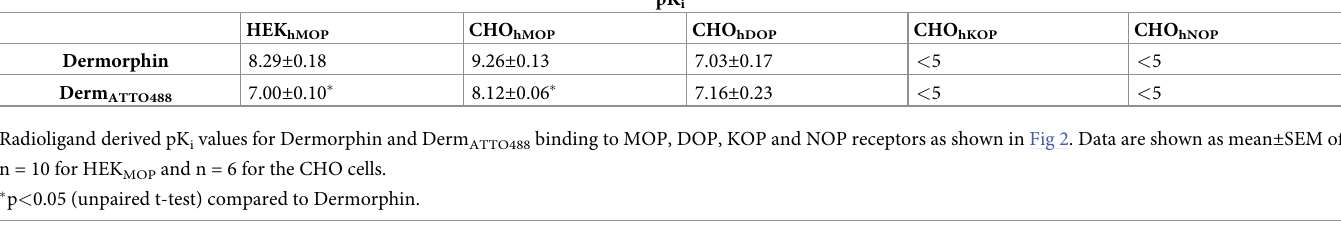
In CHO Dermorphin and Derm stimulated GTP γ [ 35 S] binding in a concentra- hMOP ATTO488 tion dependent and saturable manner. The maximal response of Derm (E 1.34) was ATTO488 max not significantly different (p > 0.05) to that calculated for Dermorphin (E 1.52), Fig 2, max Table 2. Derm and Dermorphin were equipotent (pEC 7.84 compared to 7.62; ATTO488 50 p > 0.05), Fig 2, Table 2.